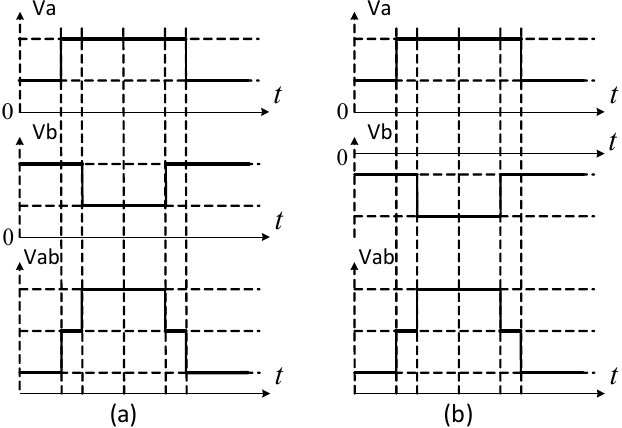
Figure 12. Different PWM phase voltages possible synchronization for PS PWM: ( a ) voltage pulses of the same polarity; ( b ) voltage pulses of opposite polarities.